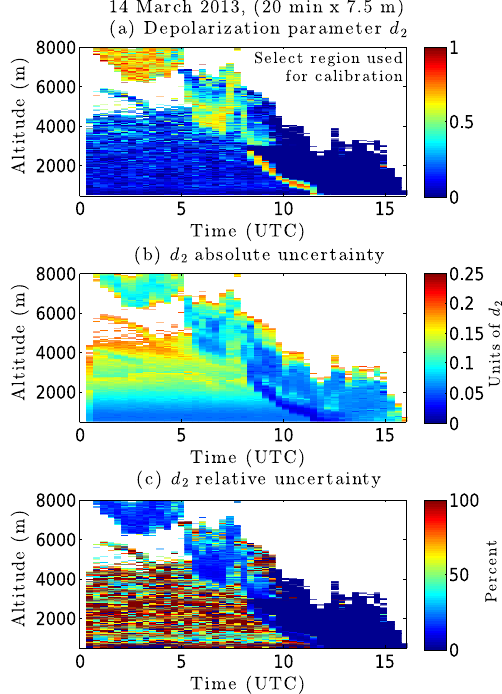
Figure 16. (a) The d 2 depolarization values from 14 March 2013, using all data available for that day to influence the calibration pro- file. (b) The uncertainties associated with the d 2 values are all in units of depolarization parameter. (c) The relative uncertainties are in units of percent.